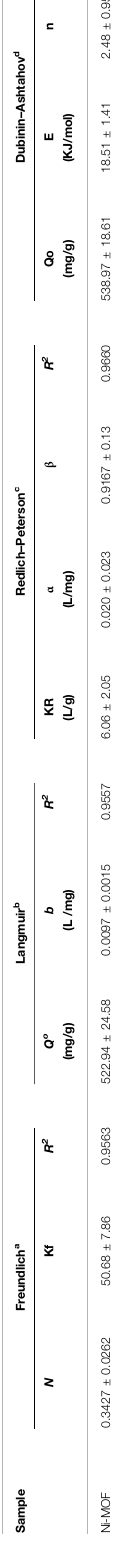
TABLE2| WeberMorrismodel fi ttingcurvesofPb 2+ adsorptionontotwodifferent MOFs.